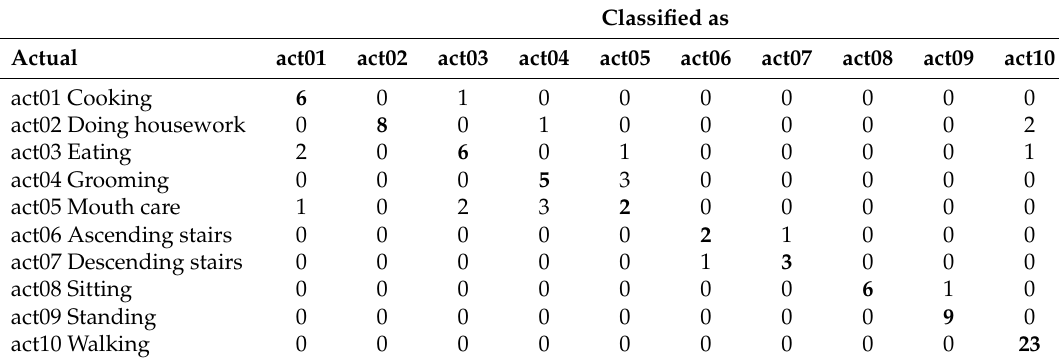
Table 7. Confusion matrix of classification results of Table 4 using AdaBoost algorithm.